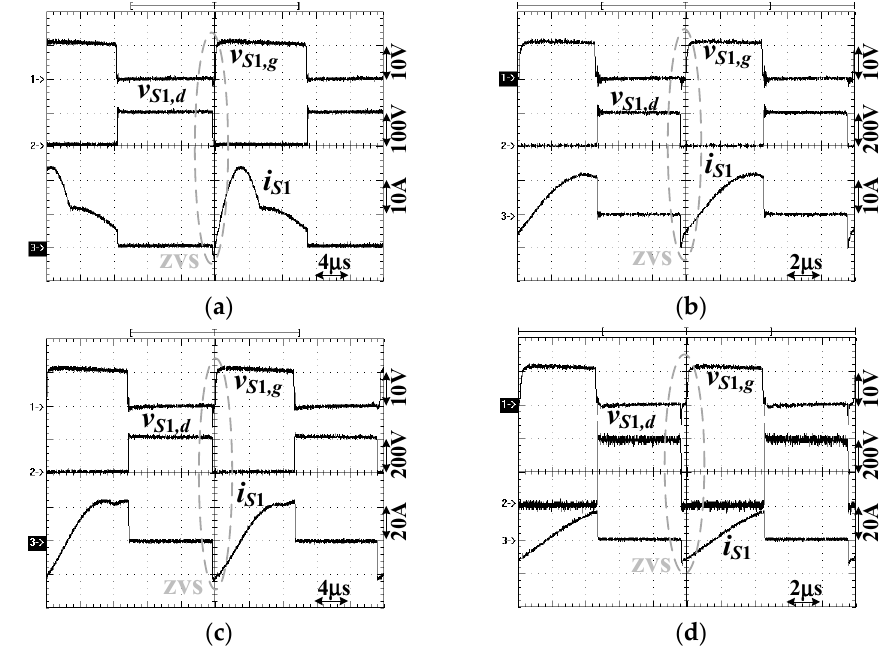
Figure 10. Measured results of v S 1 ,g , v S 1 ,d , and i S 1 at the rated power values of: ( a ) V in = 100 V; ( b ) V in = 190 V; ( c ) V in = 210 V; ( d ) V in = 400 V.